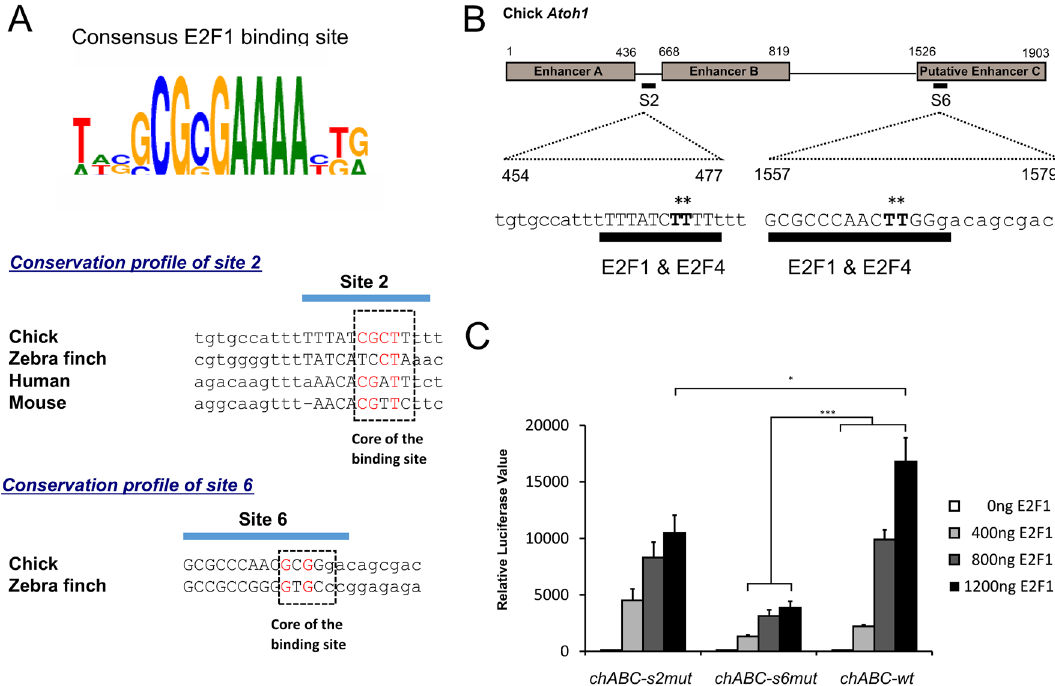
Figure 4. The effect of site directed mutagenesis of the E2F1 putative sites 2 and 6 on E2F1 mediated activation of the Atoh1 regulatory region. ( A ) Consensus seuqeunce of the E2F1 binding site described by MatInspector, Genomatix. Cross species alignment of sites 2 and site 6 in the Atoh1 regulatory regions. Conserved nucleotides within the core sequence of site 2 and site 6 are shown in red. ( B ) Diagram showing the sequence and position of putative E2F sites 2 and 6 which both contain overlapping predicted binding sites for E2F1 and E2F4. Point mutations were introduced in the core GC nucleotides, replaced with TT (marked in bold and with asterisks). ( C ) Luciferase assays show a reduced response of the chABC-s2mut (* p < 0.05) and the chABC-s6mut (*** p < 0.001) to E2F1 transfection in comparison with the wild type luciferase construct ( chABC-wt ). Each experiment was conducted in triplicate in two separate assays with different DNA preparations. Student t-test was